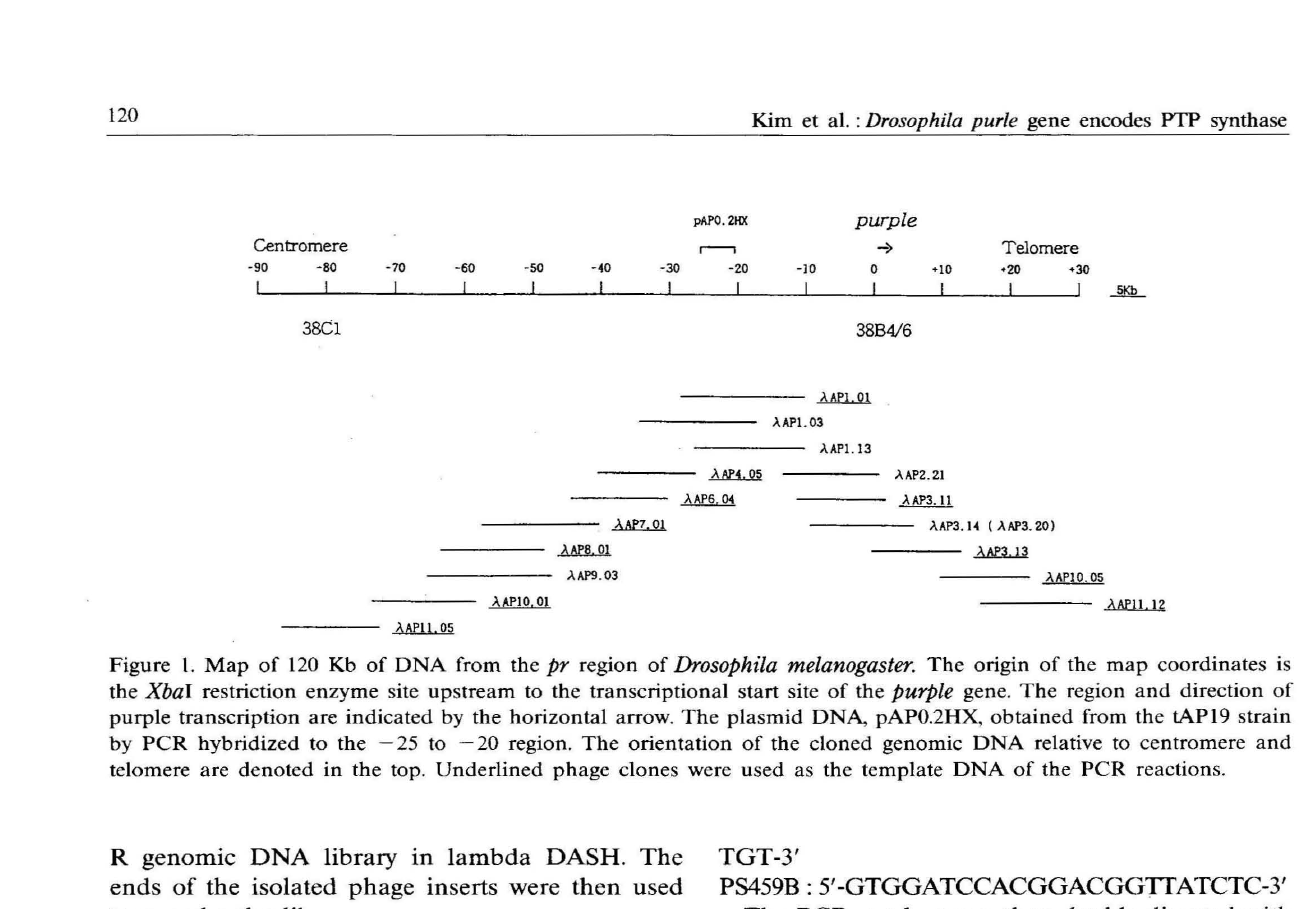
R genomic DNA library in lambda DASH. The ends of the isolated phage inserts were then used to reprobe the